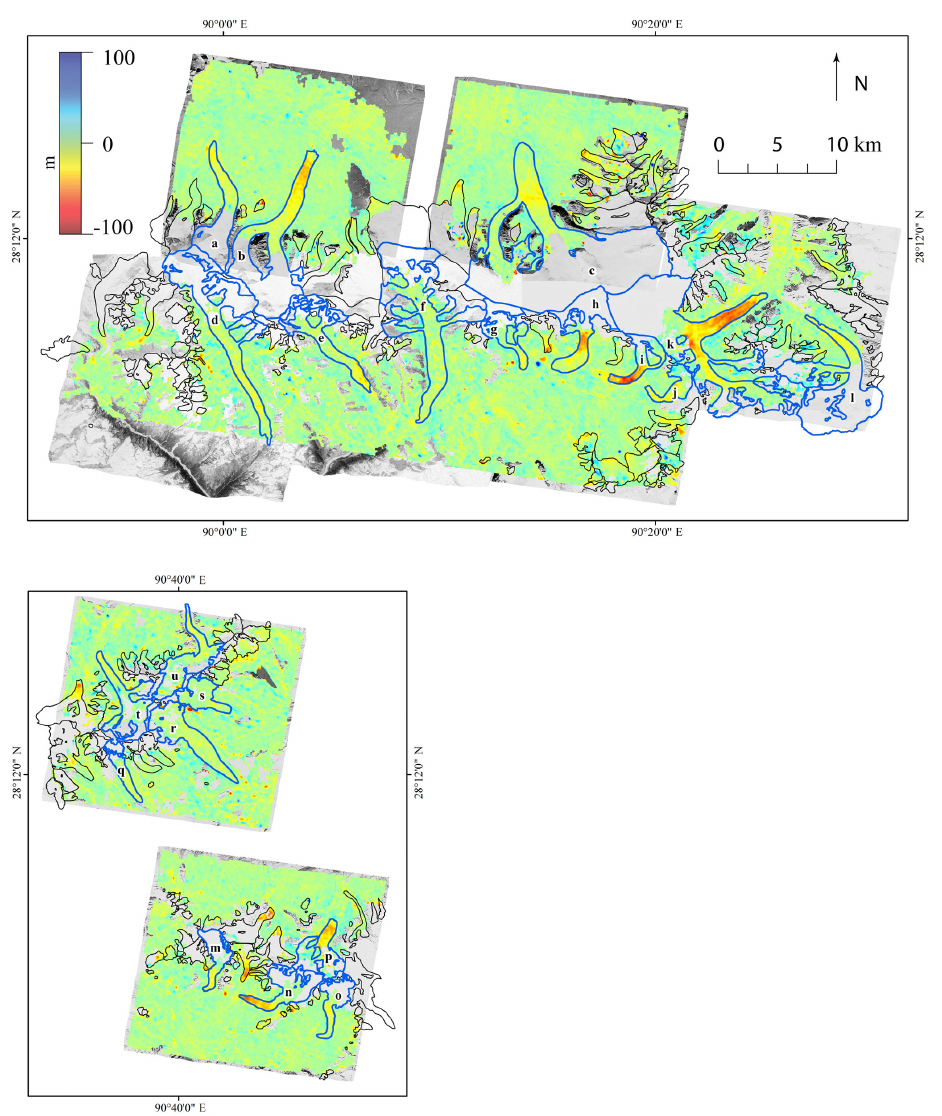
Figure 3. Elevation change maps for 2006 minus 1974. Blue outlines denote glaciers used in this study, identified by letters a–u. Note regions of missing data in glacier accumulation zones, where the stereo-matching algorithm failed due to poor radiometric contrast and oversaturation caused by snow cover. Glaciers a and b exhibit thinning near their toes, while glacier c is thinning at the transition point between a steep slope and nearly flat terrain. Three large debris-covered glaciers (d–f) show somewhat irregular patterns of thinning due to downwasting. Glaciers g–j (located in the Lunana region of Bhutan where a 1994 fatal GLOF event occurred) show significant thinning and retreating of glacier toes, which have contributed to the growth of unstable moraine-dammed proglacial lakes (glaciers g, h, and i are classified as calving glaciers in this study). Glacier k shows the greatest ice volume loss in the study region. Glaciers m–p are located in eastern Bhutan and also show significant downwasting and retreat. Glaciers q–u are the most northeastern, are mostly debris covered, and show a moderate rate of